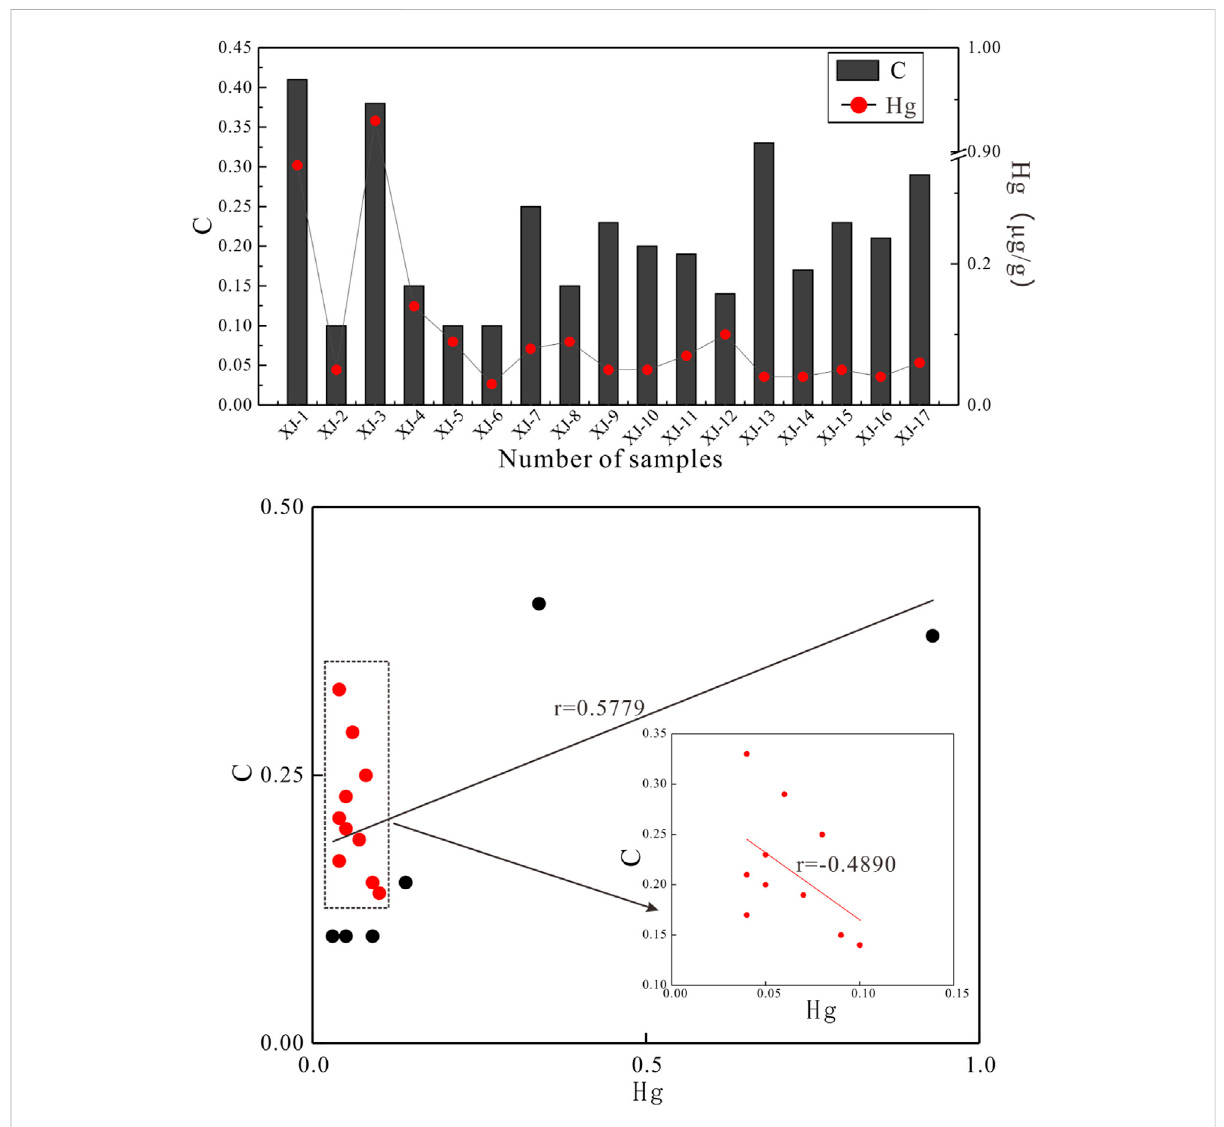
FIGURE 9 Correlation analysis of mercury and terrigenous